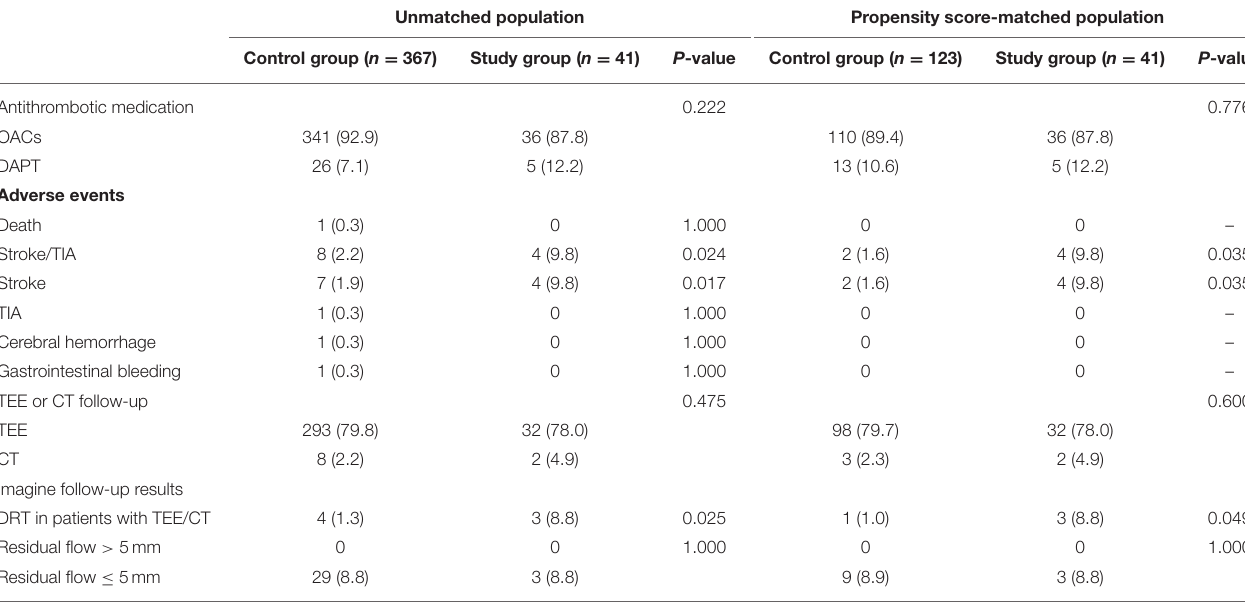
TABLE 3 | Follow-up